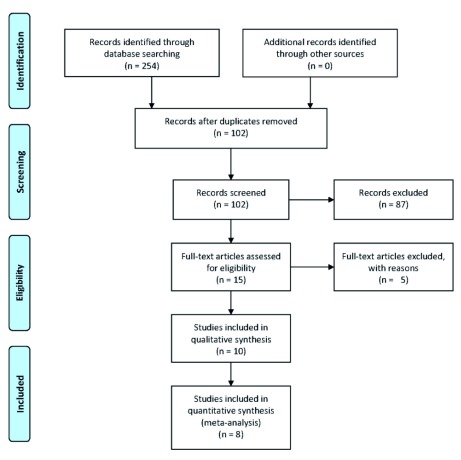
Flow chart showing study selection in the systematic and meta-analysis.